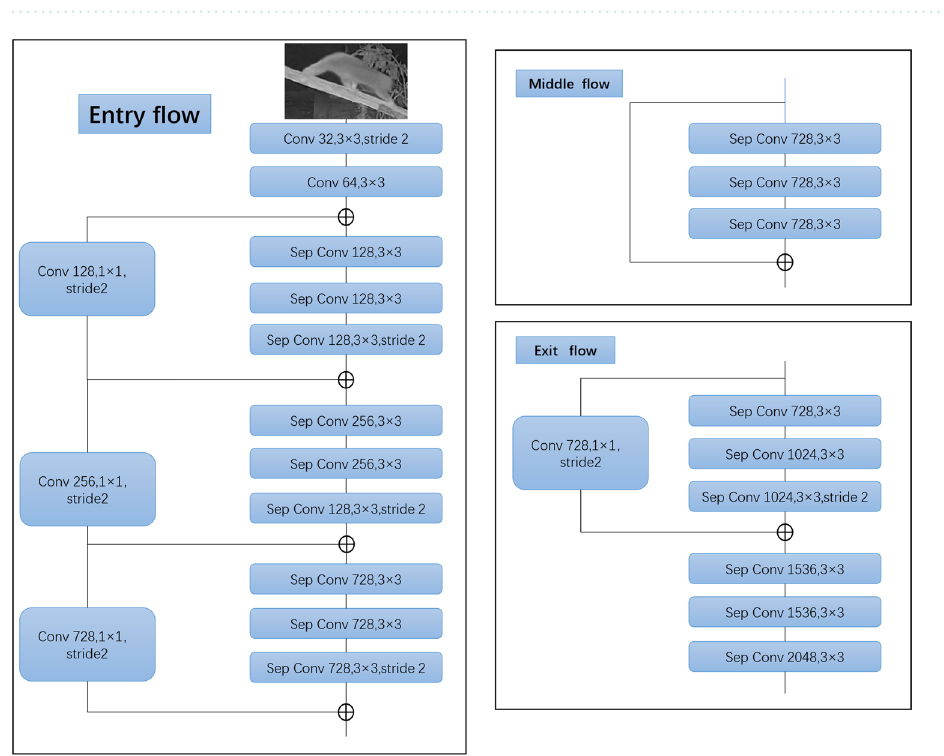
Figure 4. DeepLabv3 + network structure